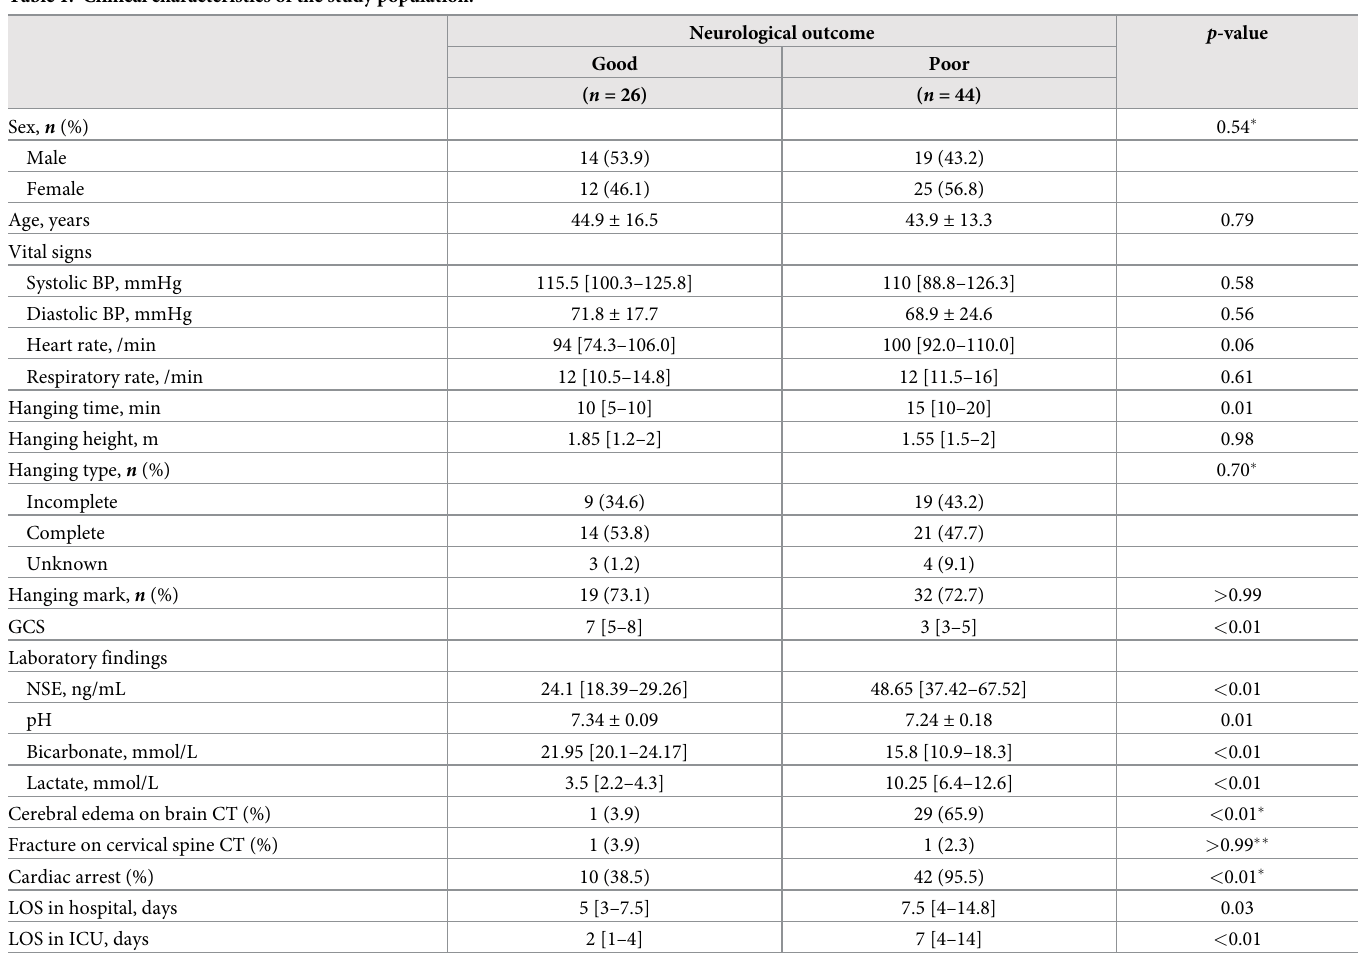
Table 1. Clinical characteristics of the study population.